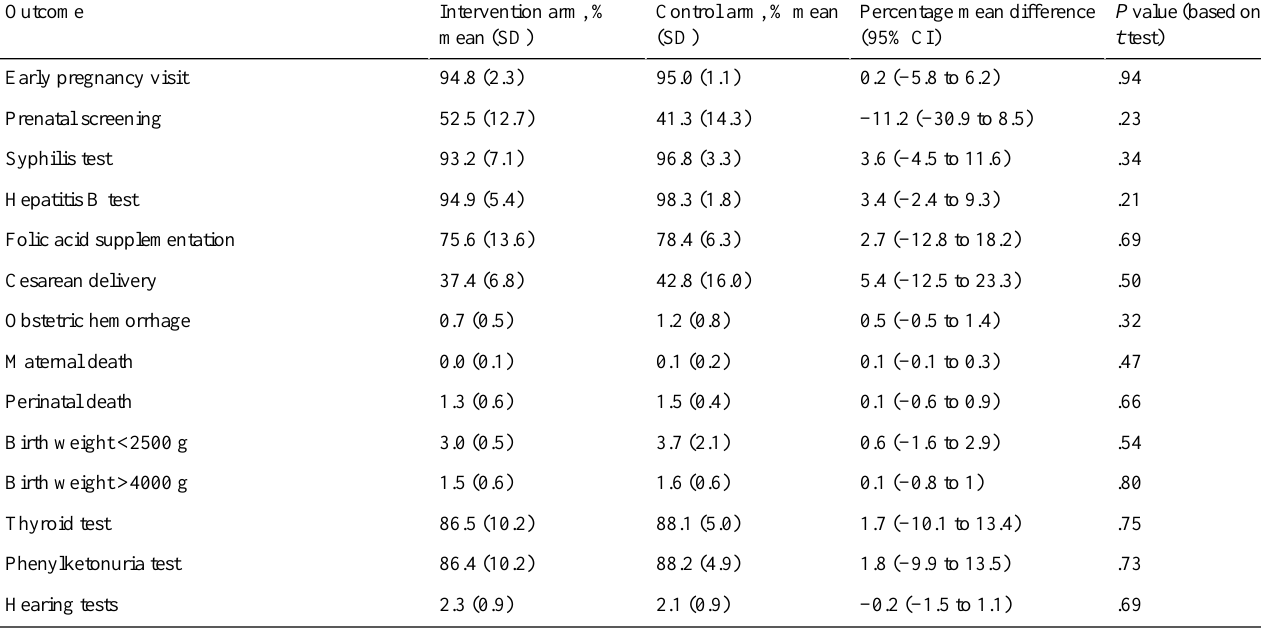
Table 2. Comparison of maternal and infant outcomes between the intervention and control arms at the county level, Hunan, China, 2011-2012.